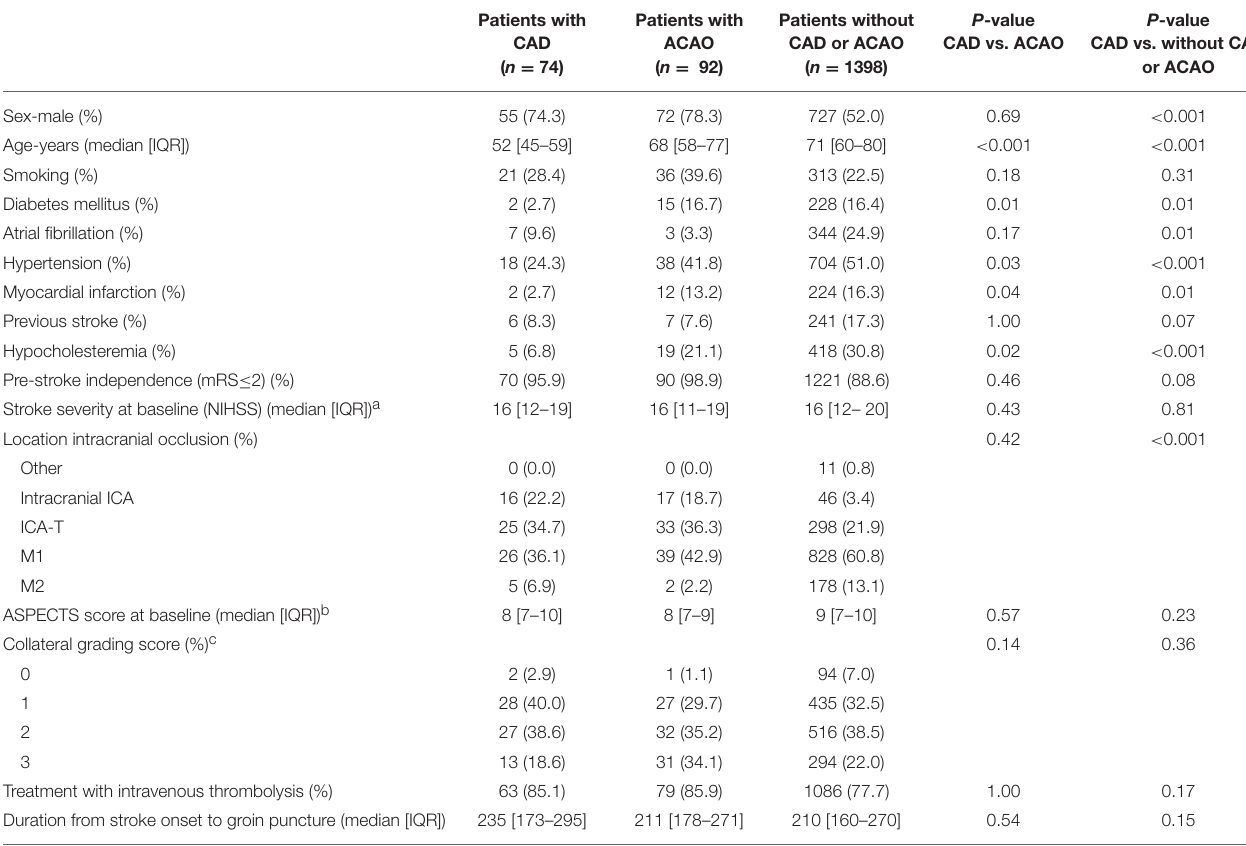
TABLE 1 | Baseline characteristics of included patients.